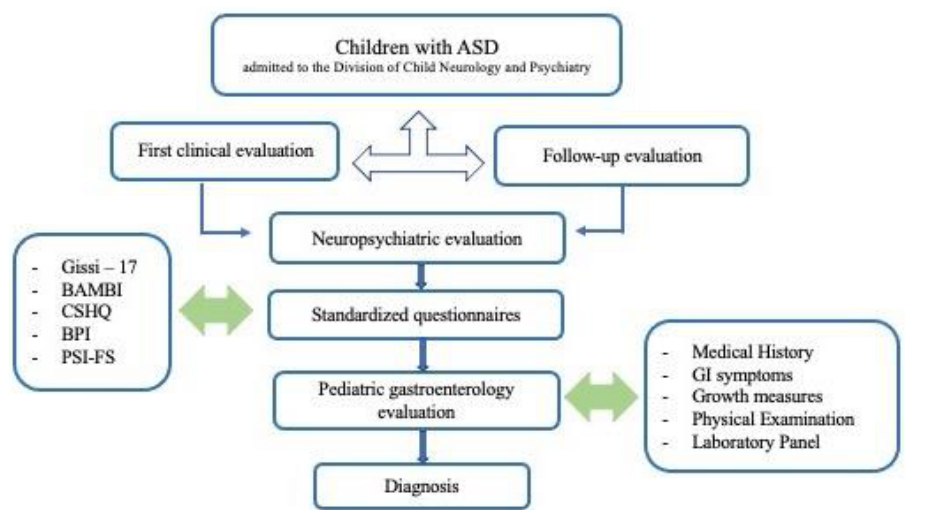
Figure 1. Figure 1 represents the study’s workflow